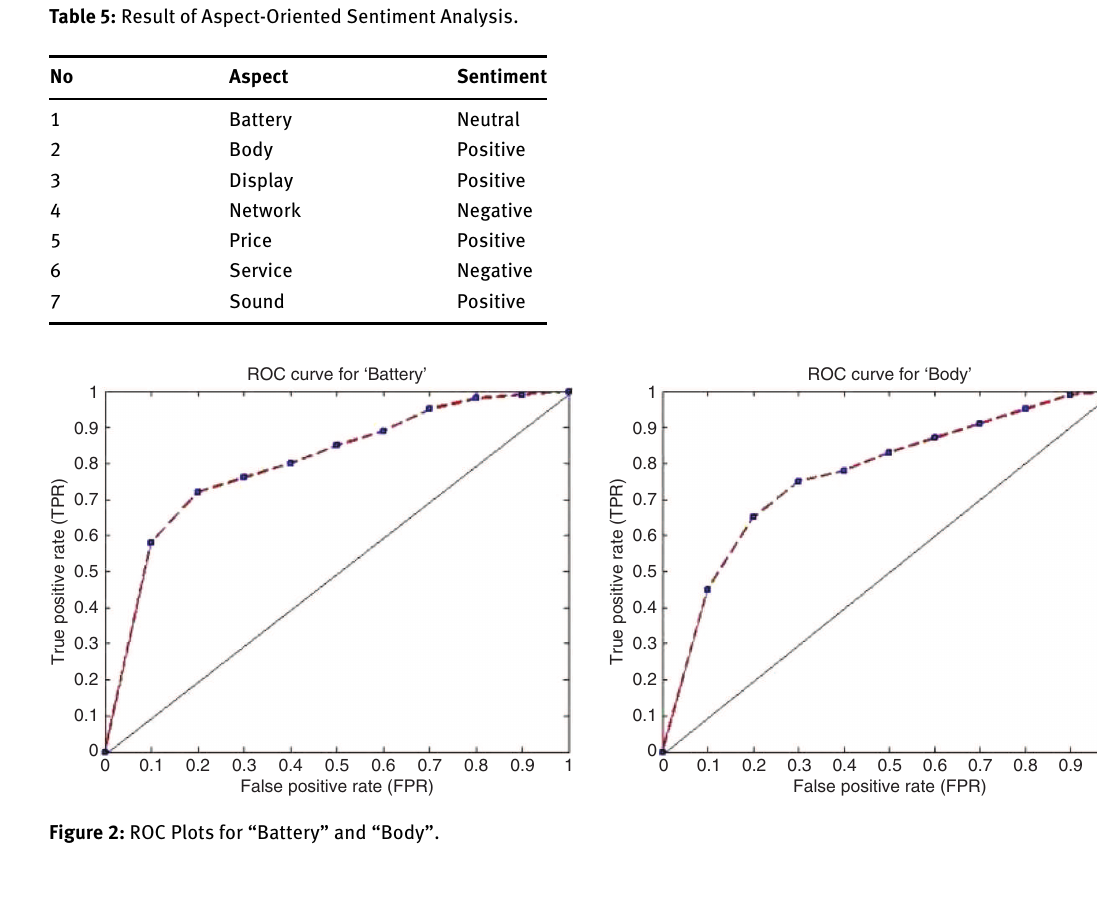
ROC curve for ‘Display’ ROC curve for ‘Network’